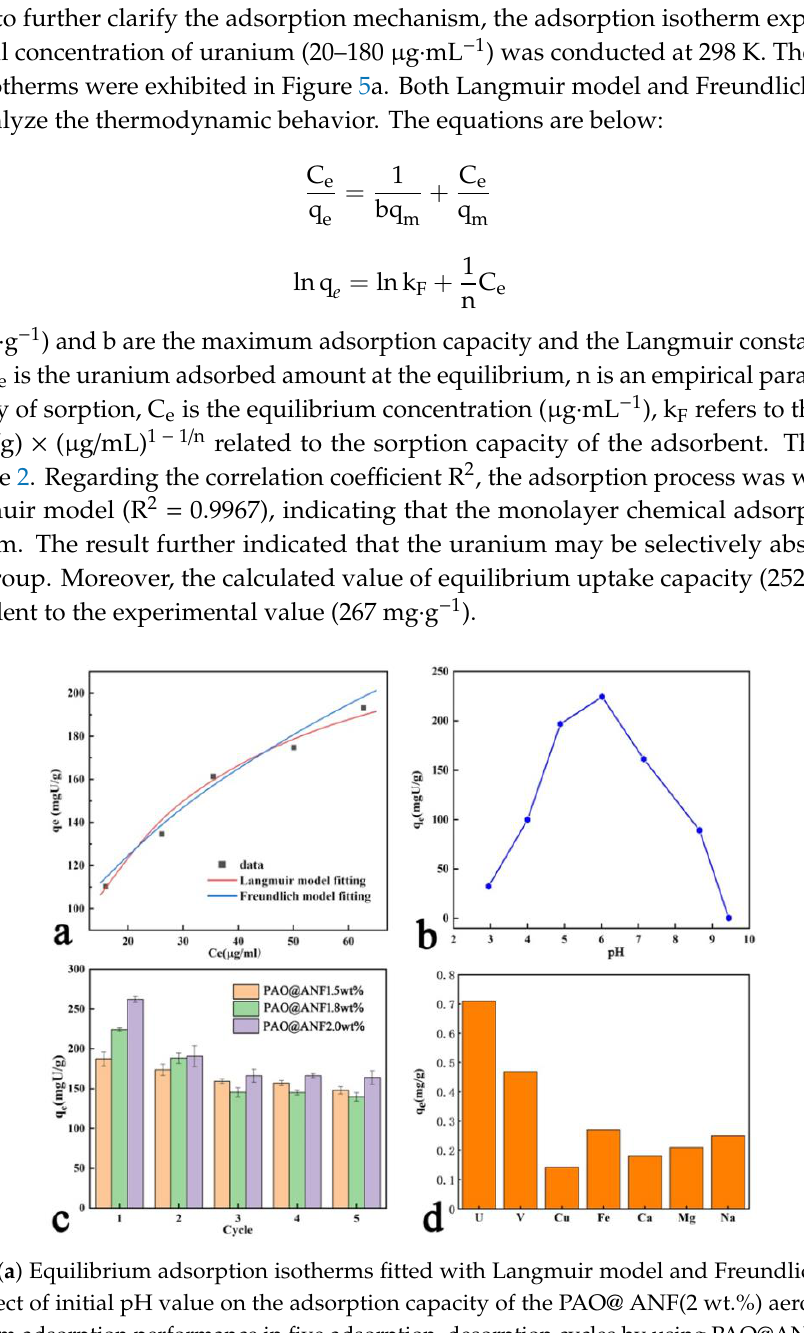
Table 2. Langmuir and Freundlich constants and correlation coefficients.